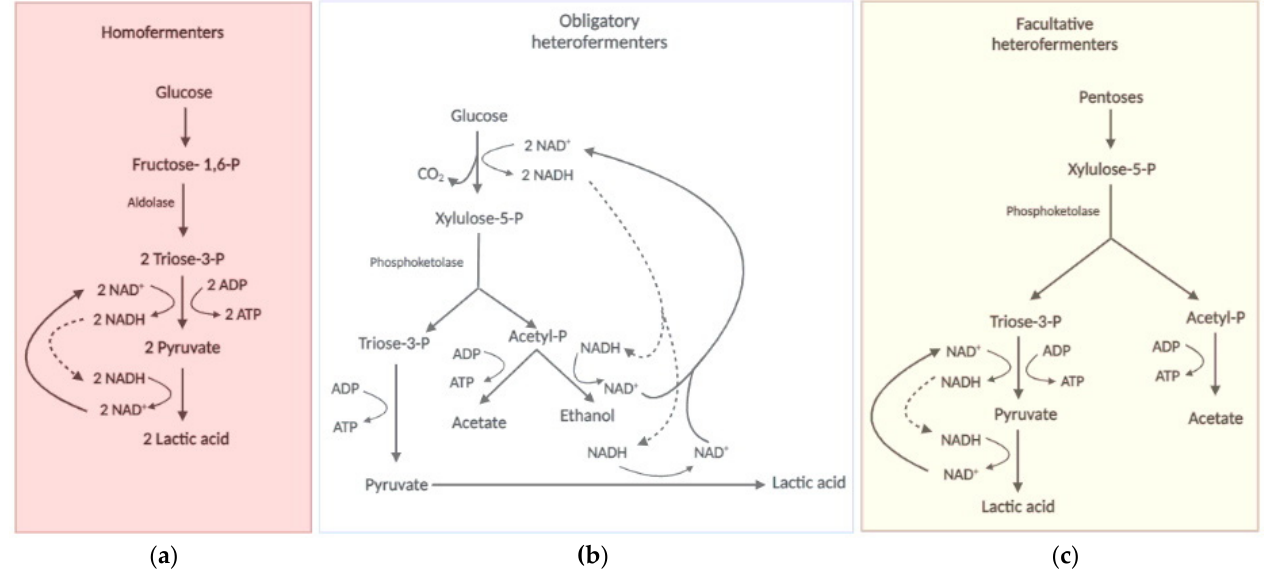
Figure 3. Types of fermentative metabolism displayed by probiotic bacteria. Exclusive homofer- menter bacteria utilize glucose or other hexoses exclusively via the glycolytic pathway ( a ). Obligate heterofermenters utilize the PPP pathway and phosphoketolase activity (PPP-PK) to metabolize hexoses and pentoses ( b ). Facultative heterofermenters use the glycolytic pathway to ferment hexoses and the PPP-PK pathway to ferment pentoses ( c ).